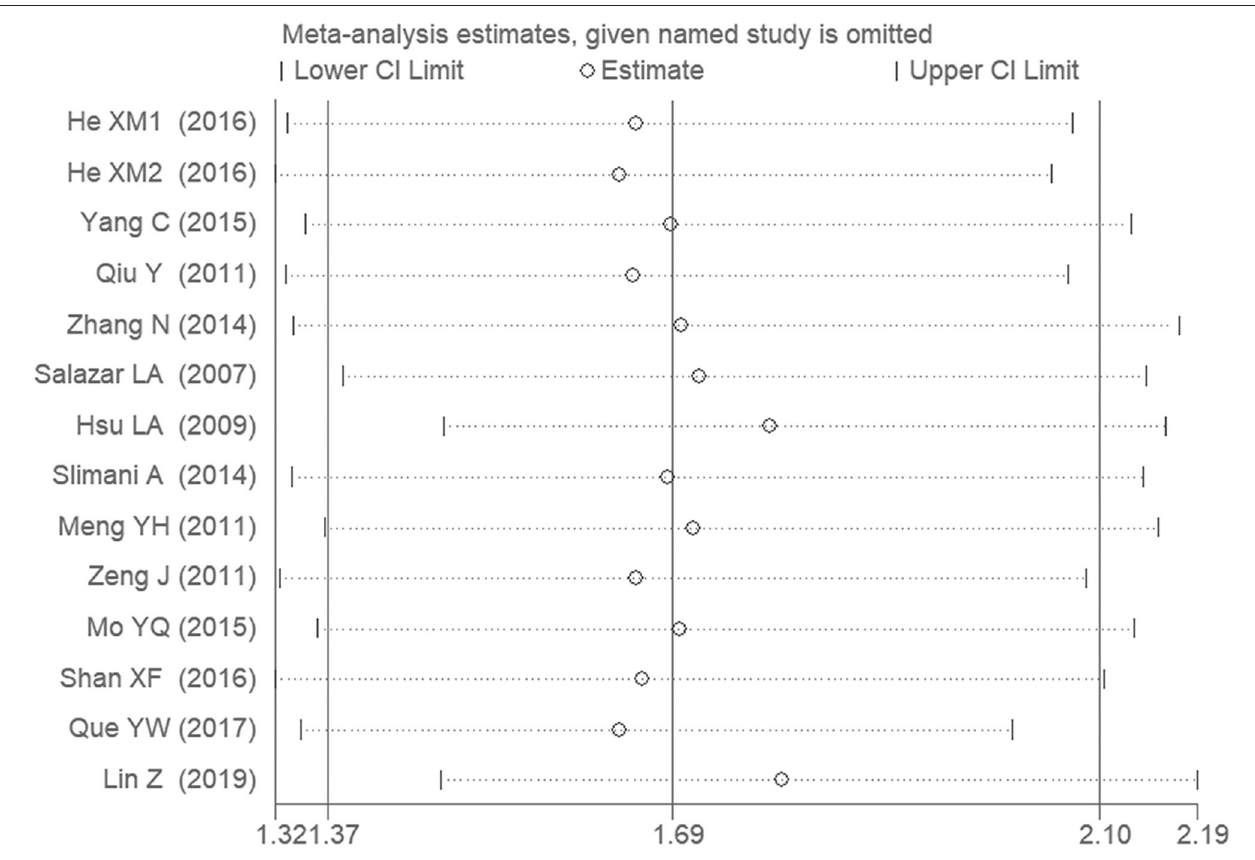
FIGURE 7 | The sensitivity analysis on the association of CAD and PCSK9 gene E670G polymorphism under an allelic genetic model (distribution of G allele frequency of PCSK9 gene E670G